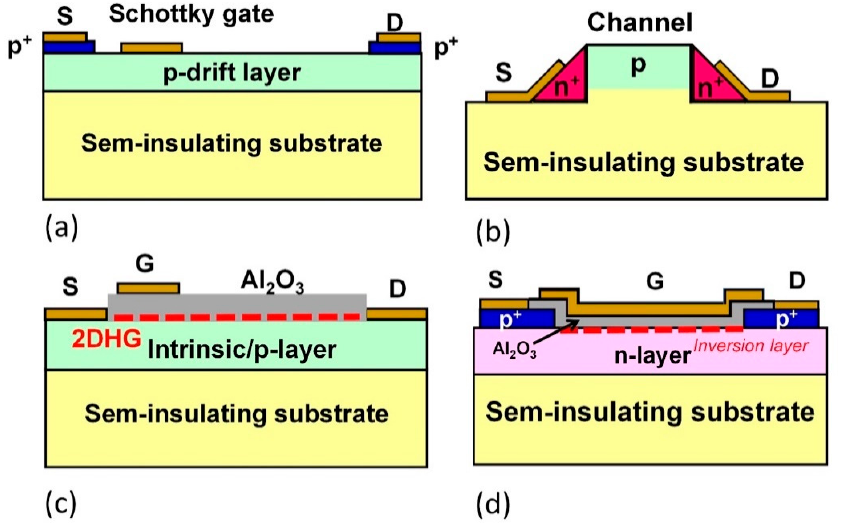
Figure 12. Schematic illustrations of diamond FETs. ( a ) MESFET. ( b ) Lateral pn junction JFET. ( c ) H-FET (C-H 2DHG MOSFET). ( d ) Inversion MOSFET. ( c ) H-FET (C-H 2DHG MOSFET). ( d ) Inversion